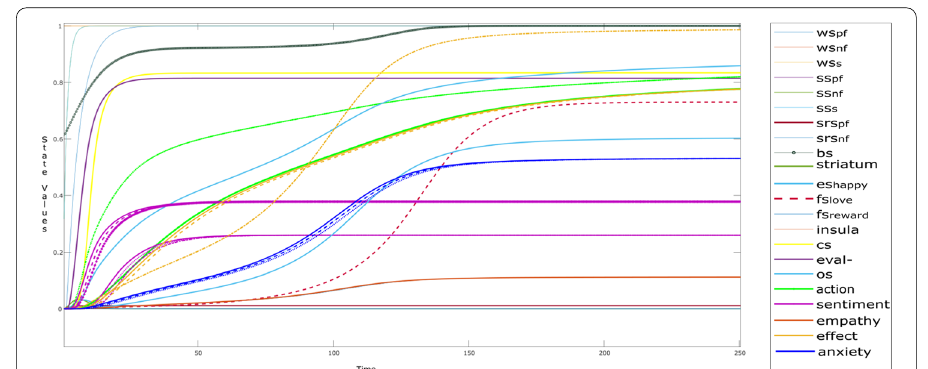
Fig. 3 Simulation of the model when ws pf